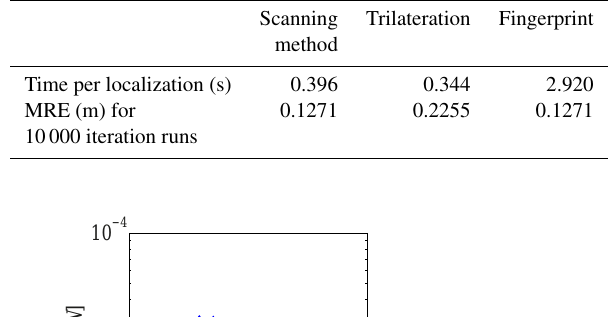
Table 2. Comparison of reviewed localization methods in terms of time and mean reconstruction error over 10000 simulation runs un- der the noisy conditions.